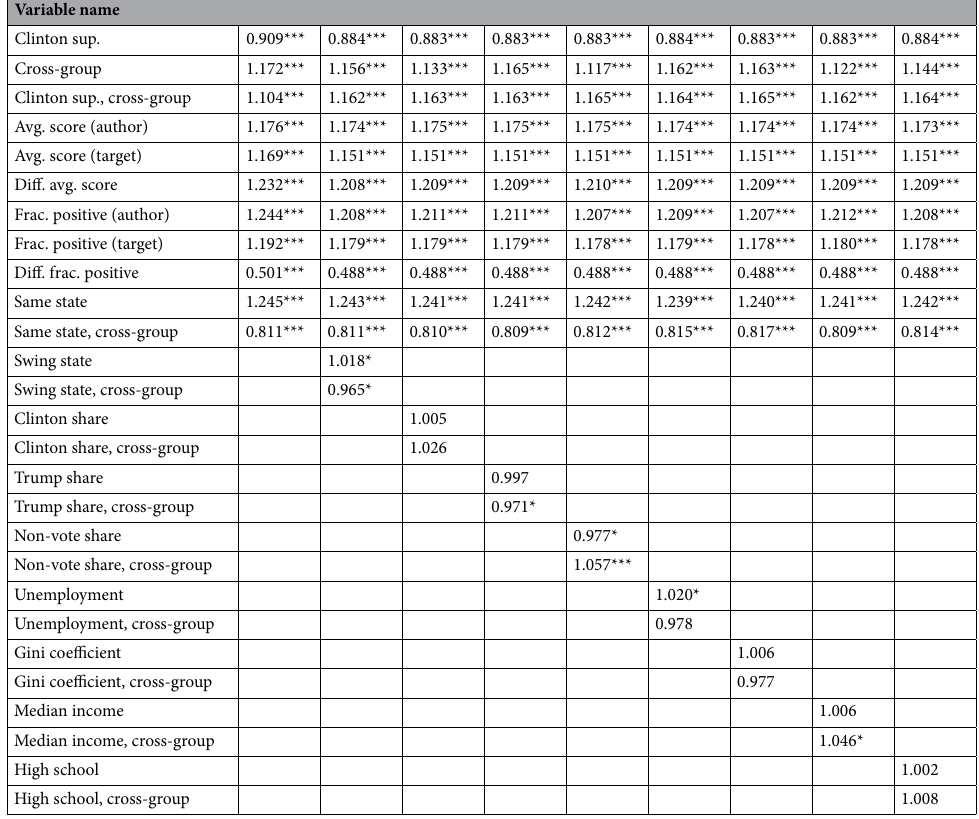
Table 3. Odds ratios obtained by logistic regression. Each column corresponds to a model with a specific set of variables. We indicate with three asterisks the statistically significant correlations ( p < 0.001 ). Odds ratios and significance are similar with or without the inclusion of the “same state” variables. Odds ratios. * p < 0.05 , *** p < 0.001